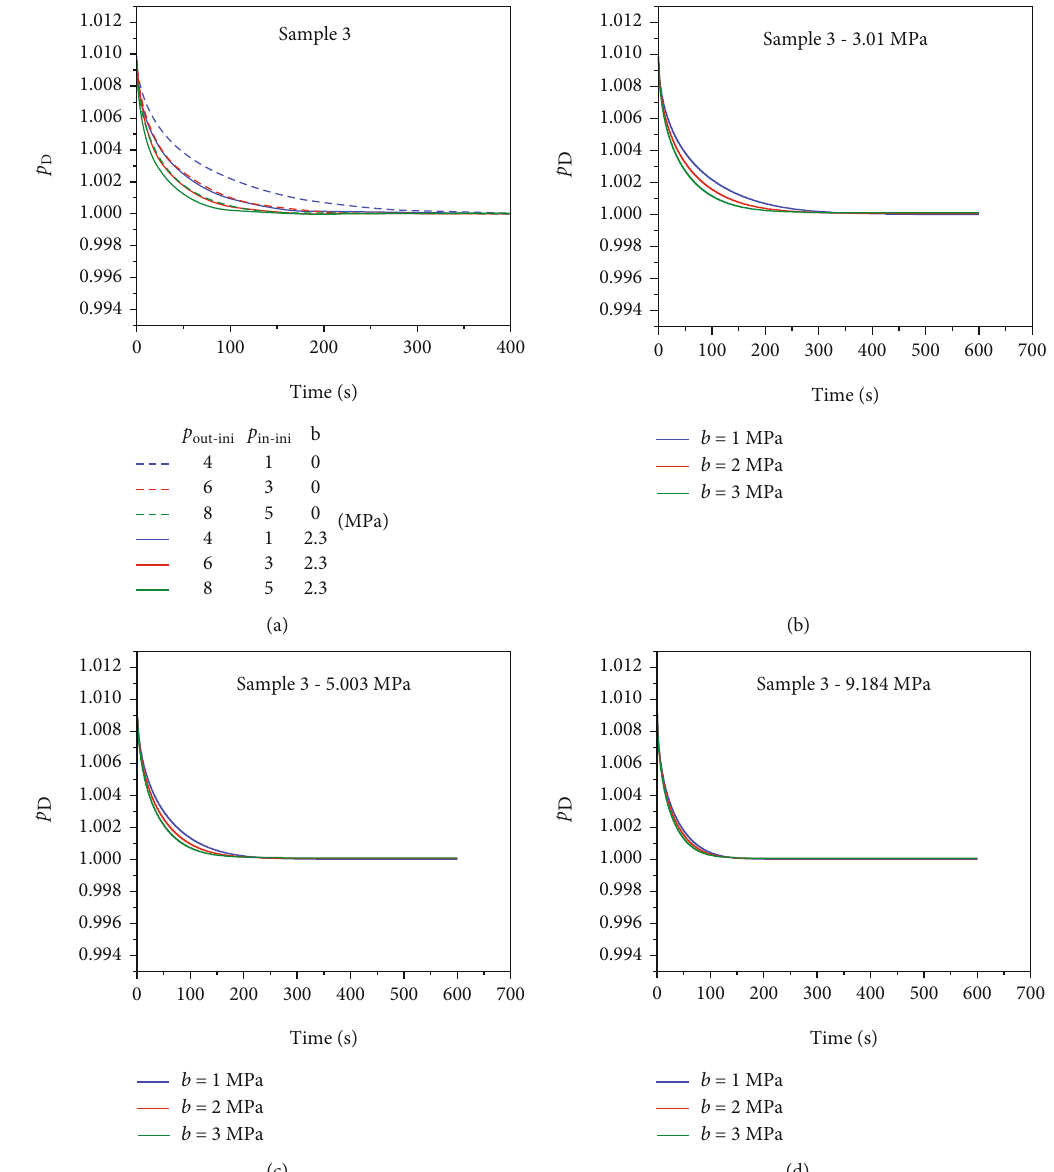
Figure 10: The impact of Klinkenberg e ff ect on gas transport in shale matrix at di ff erent pressure conditions. Di ff erent p same di ff erential pressure with and without Klinkenberg e ff ect (a). p 9.184MPa, with 1 MPa, 2 MPa, and 3 MPa Klinkenberg coe ffi